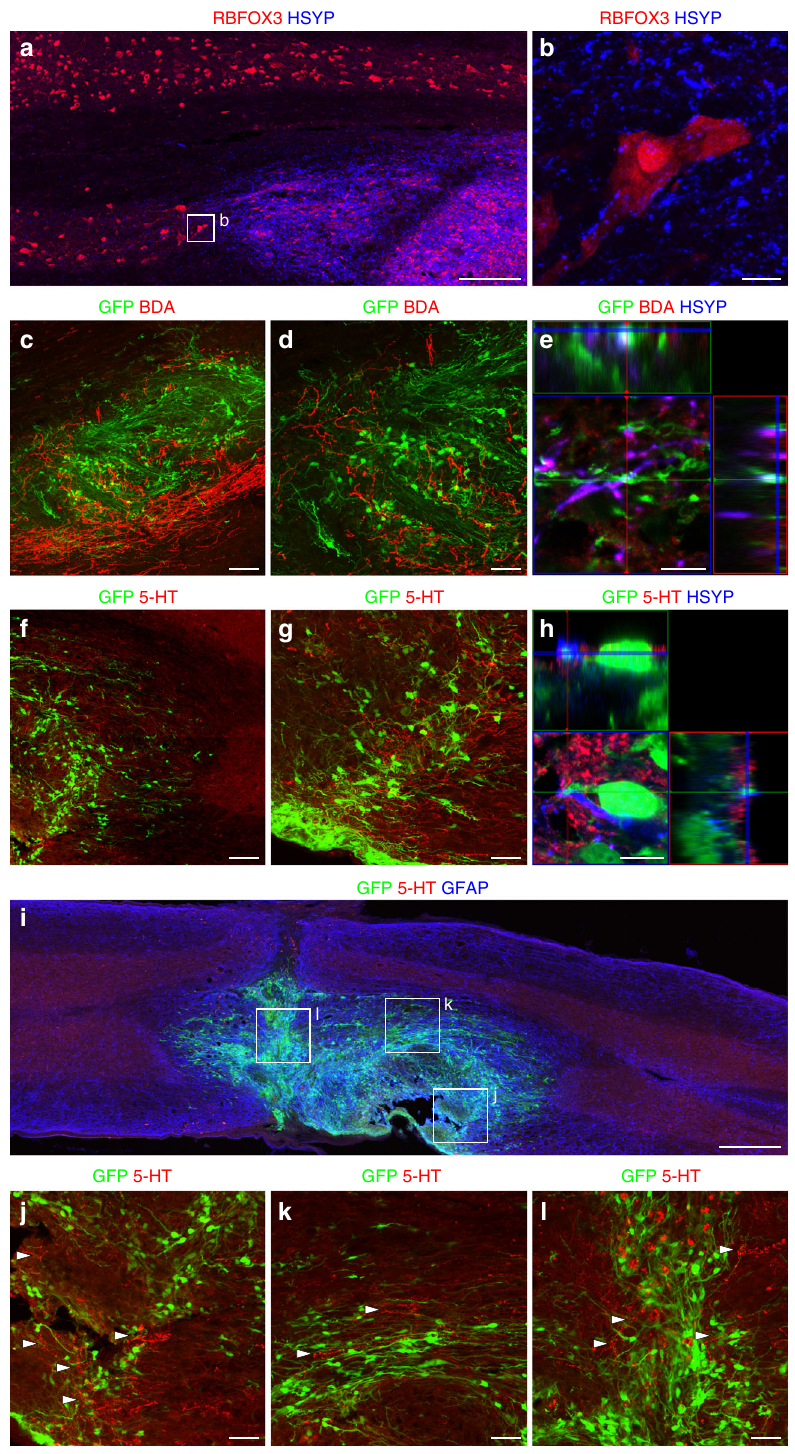
Fig. 4 Graft-Host and Host-graft interactions. a Human synaptophysin (HSYP) staining identi fi es grafted SC-NES cells. RBFOX3-positive neurons indicate the gray matter of the recipient SC. b High magni fi cation image of a host RBFOX3-positive neuron surrounded by HSYP-positive puncta, suggesting the establishment of synaptic contacts between the graft and the host. c Host corticospinal axons labeled with BDA regenerate into GFP-expressing SC-NES cell grafts. d Higher magni fi cation of BDA positive fi bers in the graft. e Adjacent signal of GFP, BDA and HSYP signal indicating the formation of novel synapses between the host CST and implanted cells. f Host serotonergic axons immunolabelled for 5-HT elongate into the GFP-positive SC-NES cell graft. g Higher magni fi cation of 5-HT positive fi bers in the graft. h Host 5-HT fi bers are proximal with HSYN and GFP-positive terminals indicating the establishment of synaptic contacts between the host raphespinal fi bers and grafted cells. i 5-HT-positive fi bers elongate through the entire length of the cell implant. Rostral is on the right and caudal is on the left. j – l High magni fi cation of boxed areas in ( i ) showing serotonergic terminals intermingled with GFP-labeled graft cells close to the rostral graft-host interface ( j ), in the middle of the graft ( k ) and in proximity of the lesion core ( l ). Arrowheads indicate 5-HT-positive fi bers. Scale bars: a 200 µ m; b 10 µ m; c 100 µ m; d 50 µ m; e 10 µ m; f 100 µ m; g 50 µ m; h 10 µ m; i 500 µ m, j – l 50 µ